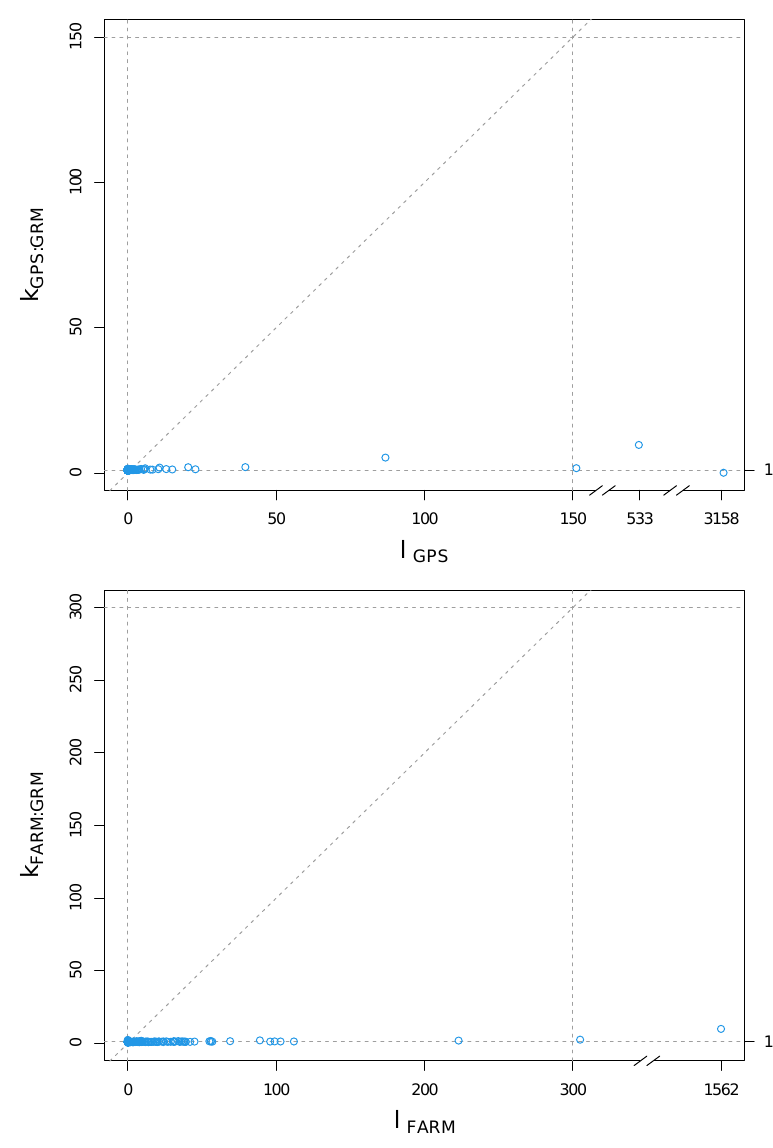
Figure 5. Scatterplots of eigen-values of the herd covariance matrix ( 𝝀 𝜂 ) by the kappa statistics ( 𝜿 𝜂:𝐺𝑅𝑀 ), in order to compare the variance structures of 𝑮 and 𝑾 𝜂 𝑾 𝜂 = 𝒁𝑬𝒁′ . 𝐺𝑃𝑆